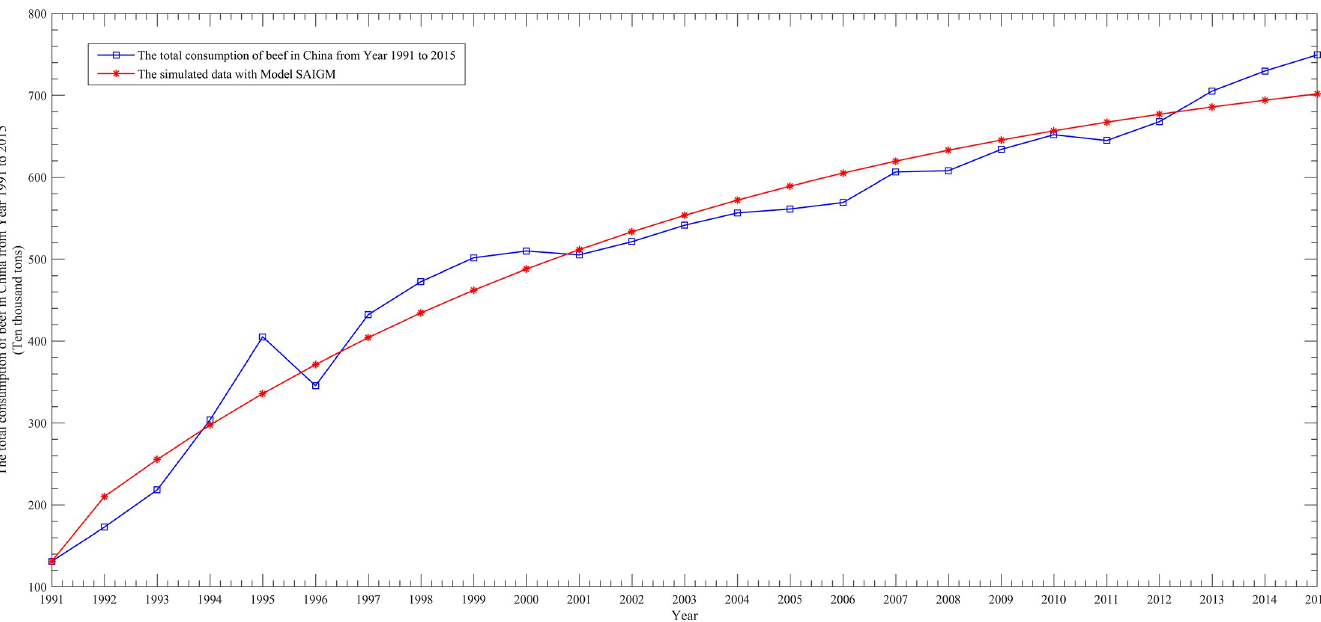
Fig 5. Curves of the actual data and simulated data of the SAIGMmodel.